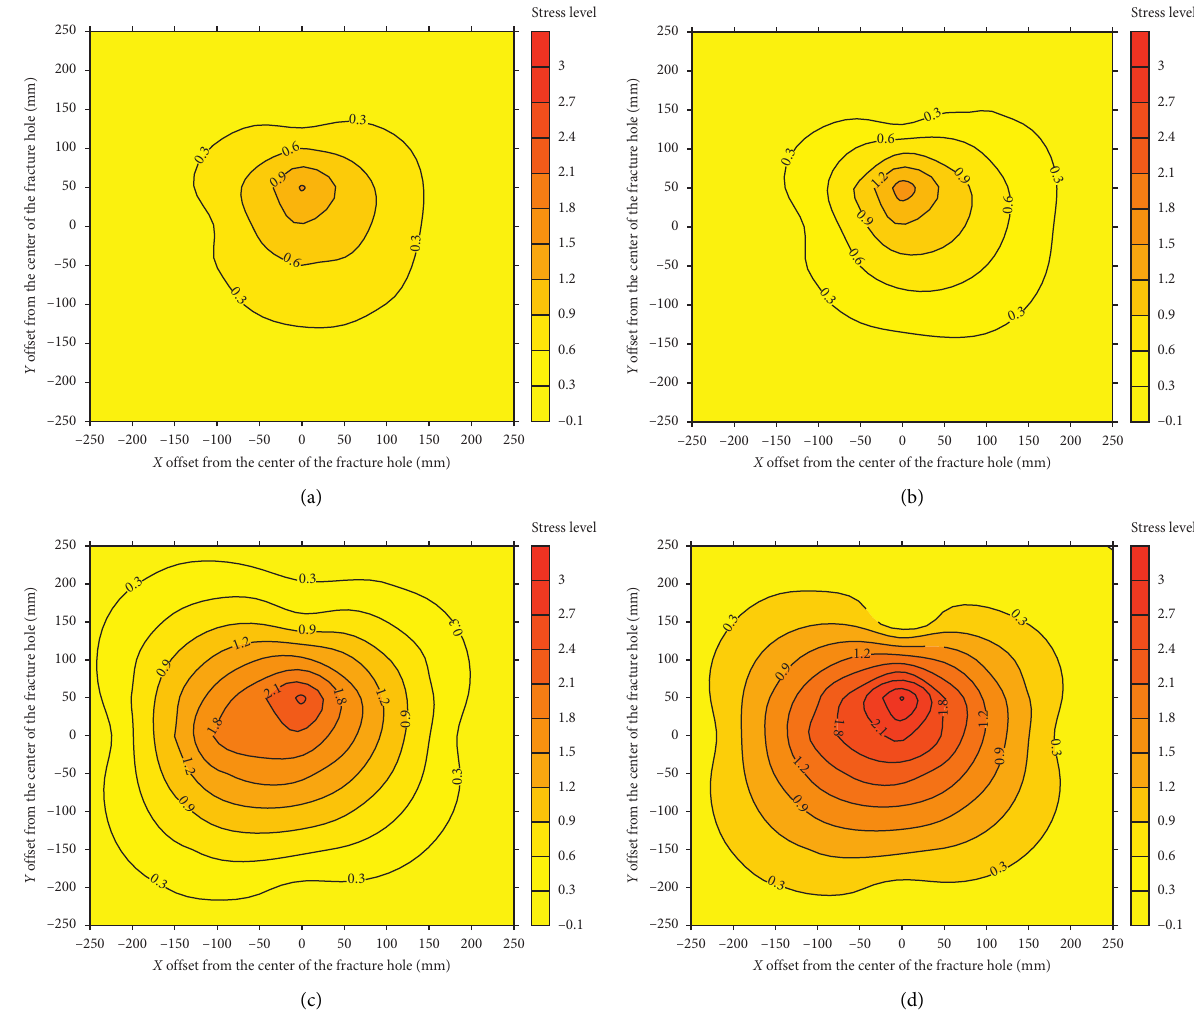
Figure 7: Cloud pictures of roof stress of coal seam for the first time fracturing: (a) t � 200s; (b) t � 800s; (c) t � 1000s; (d) t �